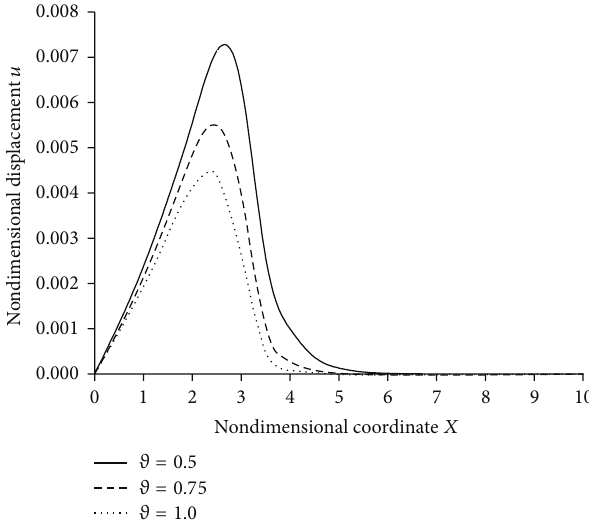
Figure 12: Nondimensional displacement distribution for different 𝜗 values.